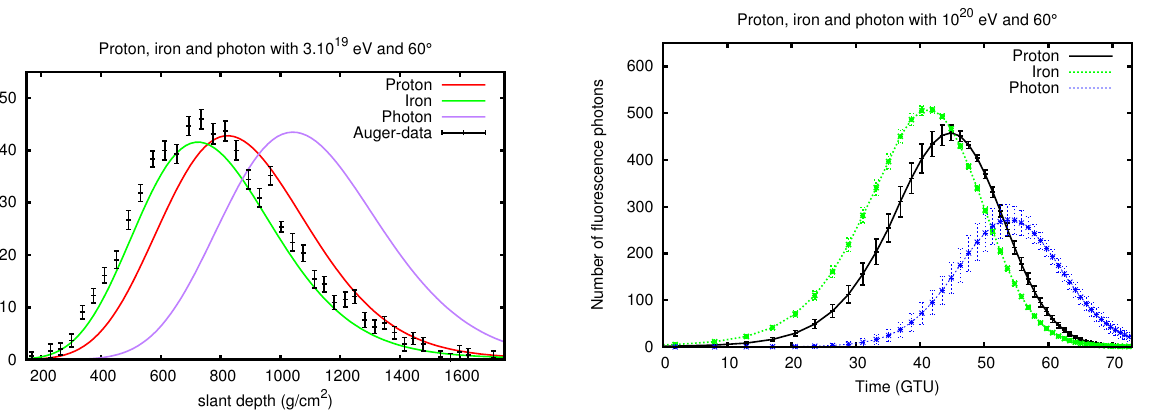
Figure 5. Profile of the average energy deposit in air for 500 Figure 3. Number of charged particles given by GHEISHA alter- EAS initiated by primary particles, proton, iron and photon, with natively combined with high energy hadronic interaction models energy E = 30 EeV and zenith angle θ = 60 ◦ . Experimental data QGSJETII-04, EPOS and SIBYLL, for an incoming primary iron points are taken from [11]. with E = 10 19 eV and θ = 60 ◦ .